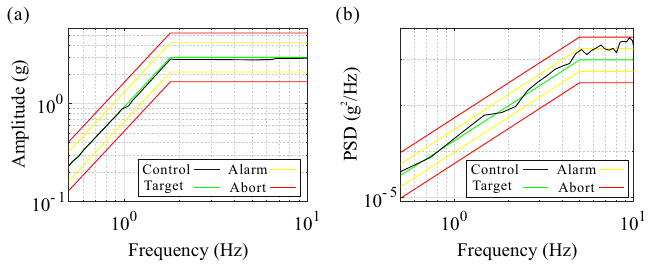
Figure 8. Target spectrum of the control signal ( a ) for the frequency-sweep experiment, ( b ) for the random vibration